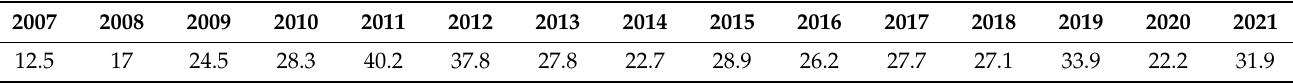
Table 1. Trend of the renewable electricity capacity additions (in GW) in Europe (2007–2021). Based on IEA Renewable